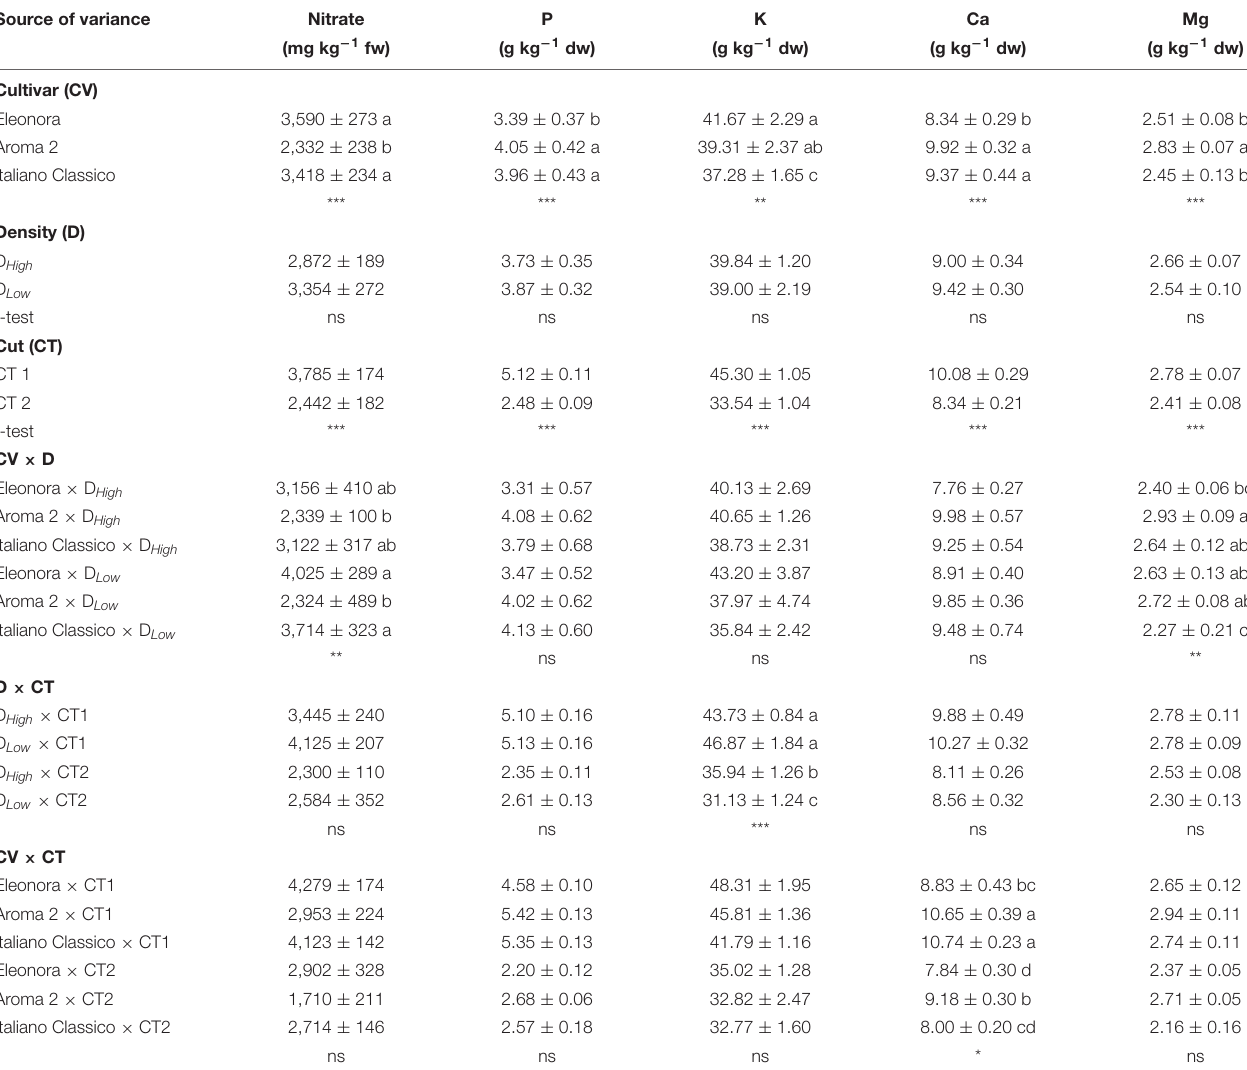
TABLE 4 | Nitrate and mineral content of Genovese basil cultivars Eleonora, Aroma 2, and Italiano Classico in light of density and cut treatments. Source of